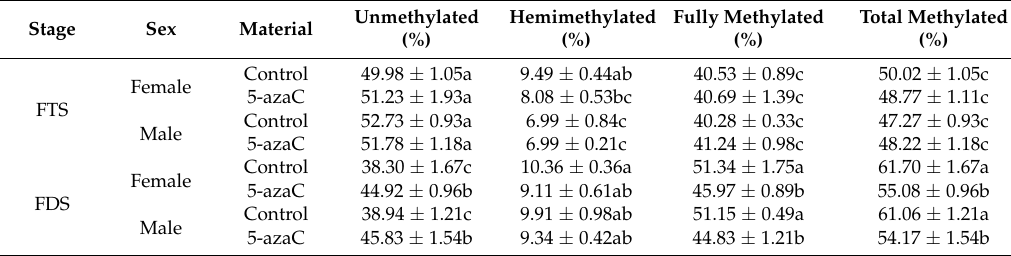
Table 3. Effects of 5-azaC on methylation level in female and male Salix viminalis